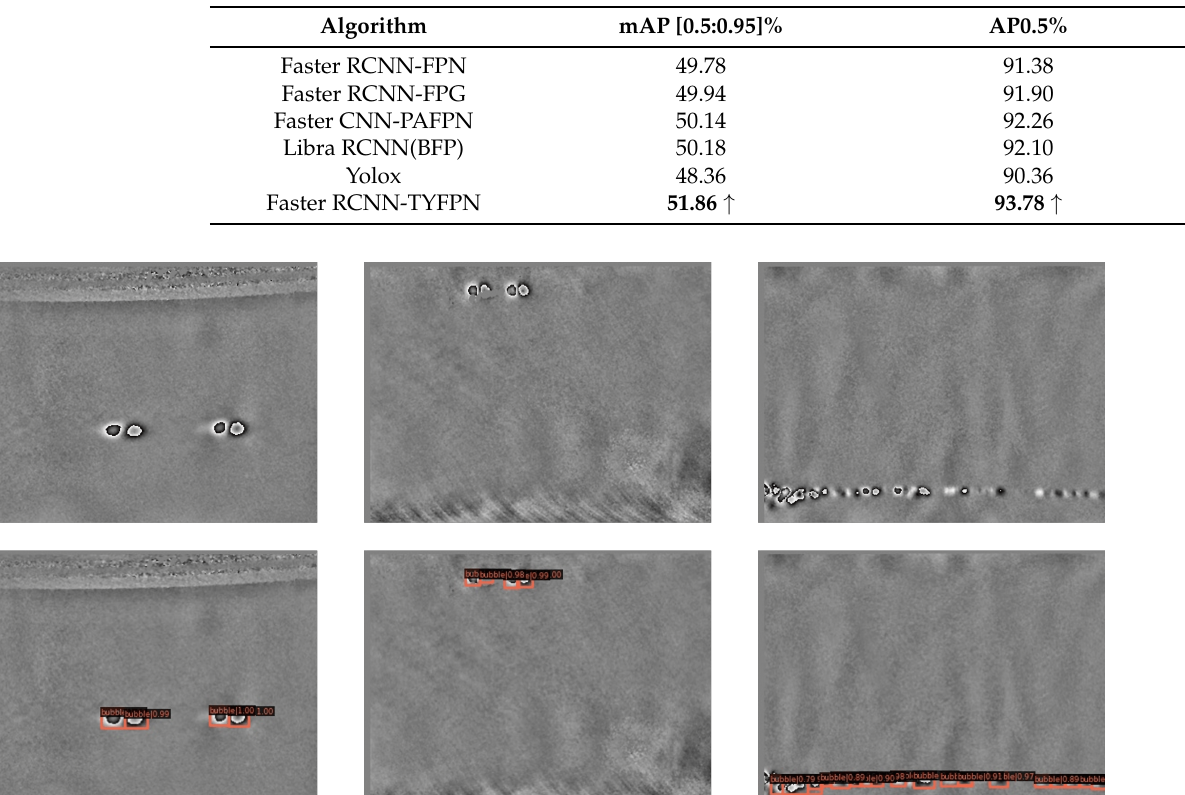
Table 5: for different backbones, when TYFPN is used, the detection effect is improved to varying degrees. Under the condition of using TYFPN as the neck, when ResNet50 is the backbone, the detection results are the best; when ResNet101 is the backbone, the detection results are very close to those when ResNet50 is the backbone. However, the amount of network parameters of ResNet101 is much larger than that of ResNet50, so we finally use ResNet50 as the